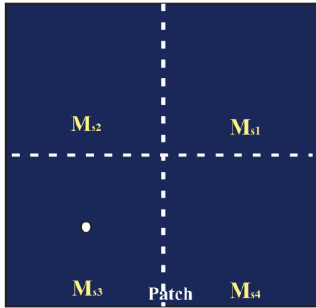
Figure 6. Analyzing the radiating patch as four magnetic